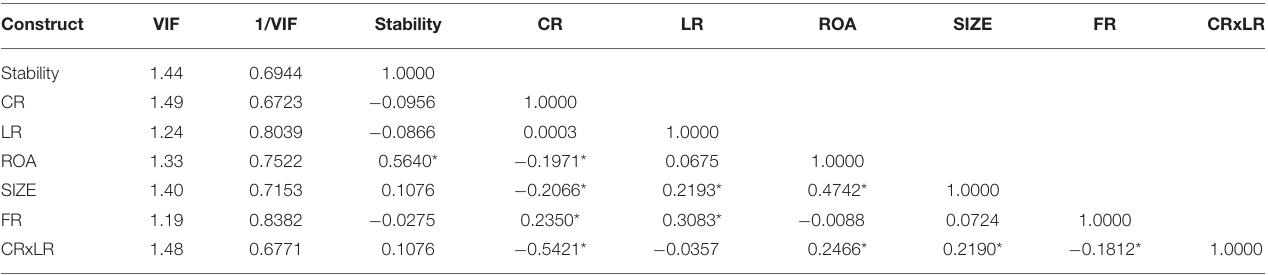
TABLE 3 | The variance inflation factor (VIF) and correlation coefficient.